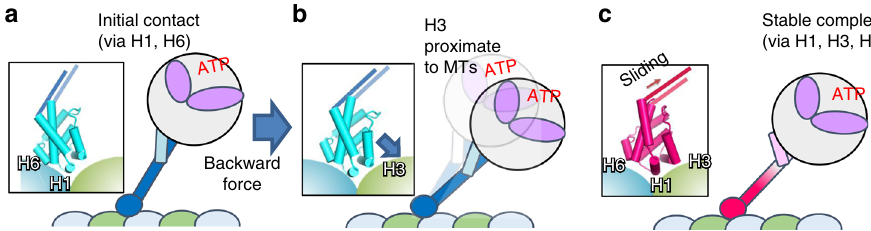
Fig. 7 A model for the directional bias for the applied forces and movement direction of dynein. a MTBD of dynein makes an initial attachment via a weak-binding interface (H1 and H6). b Backward force or diffusive search in the forward direction tilts MTBD, rendering H3 proximate to the binding site of β -tubulin (indicated by an arrow). c MT binding by MTBD via a strong-binding interface (H1, H3, and H6) induces the sliding of CC1, which would transmit the signal toward the ATPase domain to facilitate ATP hydrolysis and the release